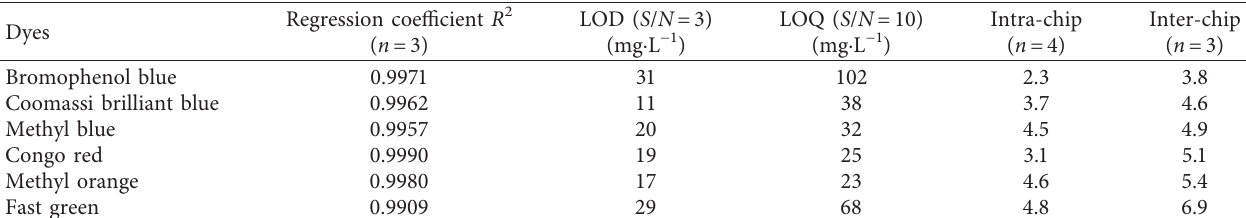
Table 3: Limit of detection (LOD), limit of quantitation (LOQ) values, linearity of the analytical detection for the different dyes, and the intrachip (run-to-run) reproducibility and inter-chip (chip-to-chip) reproducibility of the polycarbonate microchip containing the CuBTC- monopol monolithic